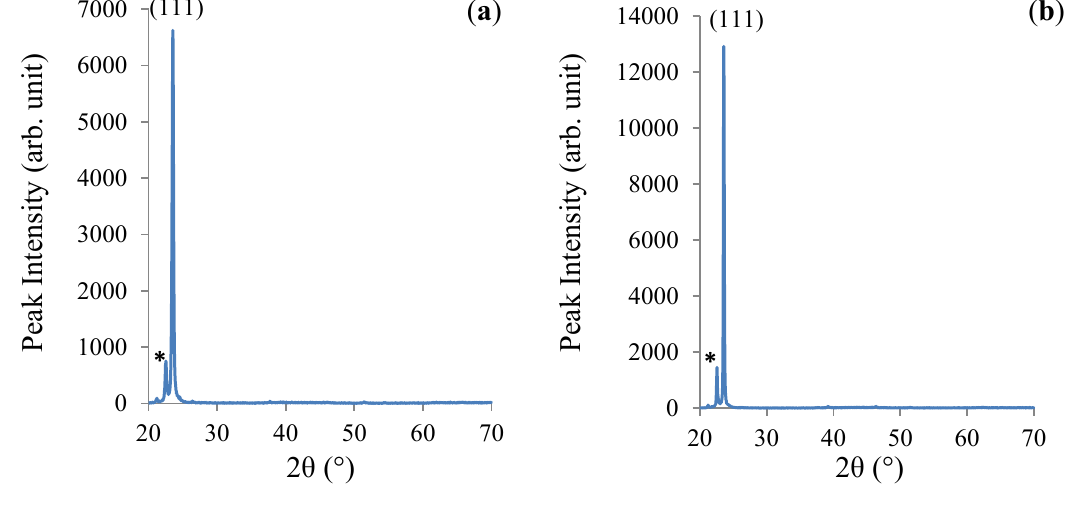
treatment. Note the increase in 2 2